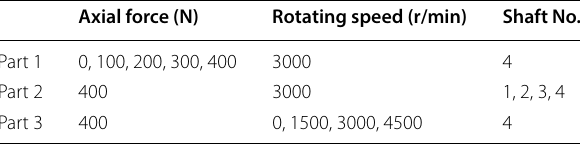
Table 2 The detailed setup for the numerical simulation Axial force